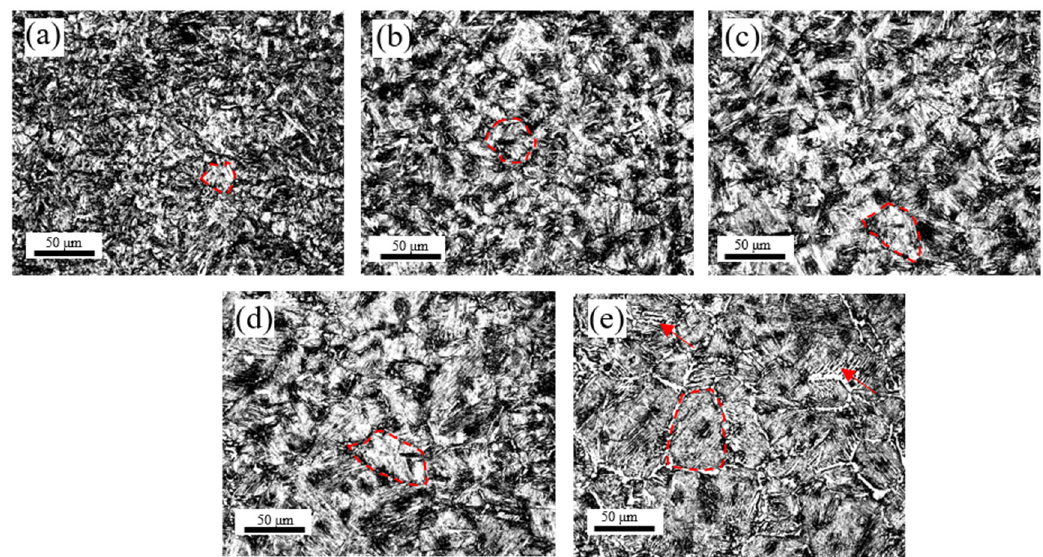
Figure 7. The martensite microstructure obtained after different austenitization temperatures at ( a ) 900 °C, ( b ) 950 °C, ( c ) 1000 °C, ( d ) 1100 °C, ( e ) 1200 °C. Red arrow in ( e ) marks the Widmanstätten ferrite. Red dotted line marks the prior austenite grain boundaries.